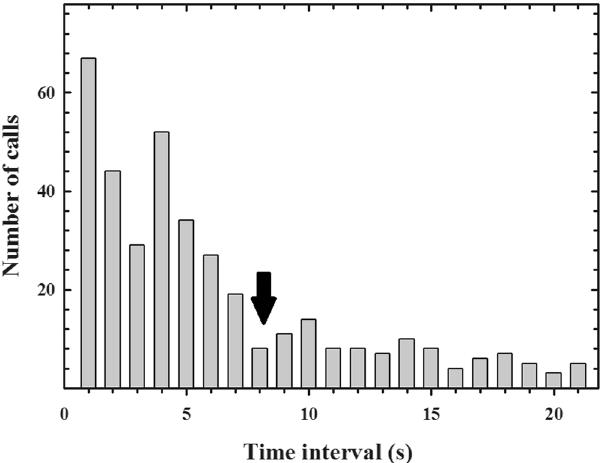
Figure 4. Distribution of the interval between individual offshore calls within 20 seconds. The arrow denotes the criterion (8 seconds) to integrate adjacent notes into a bout. The bin size is 1 second.